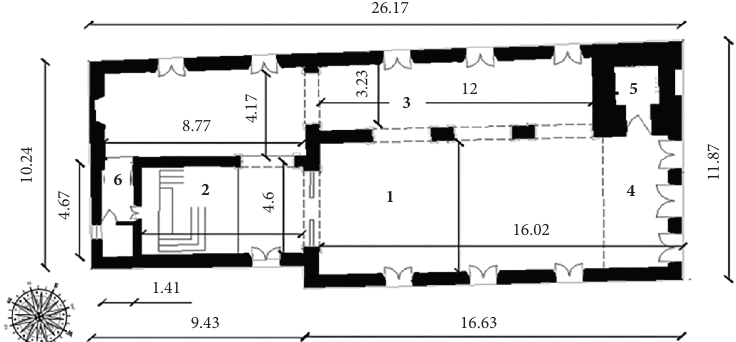
Fig. 3. Schematic cut of geometry of the Nossa Senhora das Dores Church, where 1 is the Central Nave, 2 is the Altar-Mor, 3 is the lateral Nave, 4 – is the Coro-Alto, 5 is the bell-tower and 6 is the office